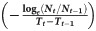
Survivorship curves of rainbow trout and their mortality rate (−loge(Nt/Nt−1)Tt−Tt−1) at times of t observations in a challenge experiment with stressors of heat and absence of food. (A) Survivorship based on mortality endpoint. (B) Surrogate survivorship based on LOE endpoint. (C) Mortality rate. (D) LOE endpoint rate. Modeled survivorship (purple) is a mixture model of two Gompertz functions (Eq. 1), respectively for early (red) and late (blue) subgroups.